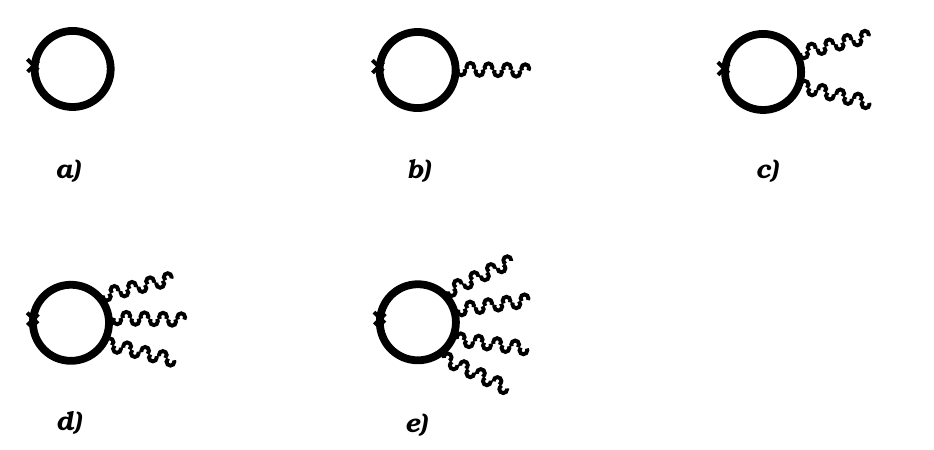
Figure 1 . Diagrams contributing to the average of (6.11) or (7.2) over the regulator